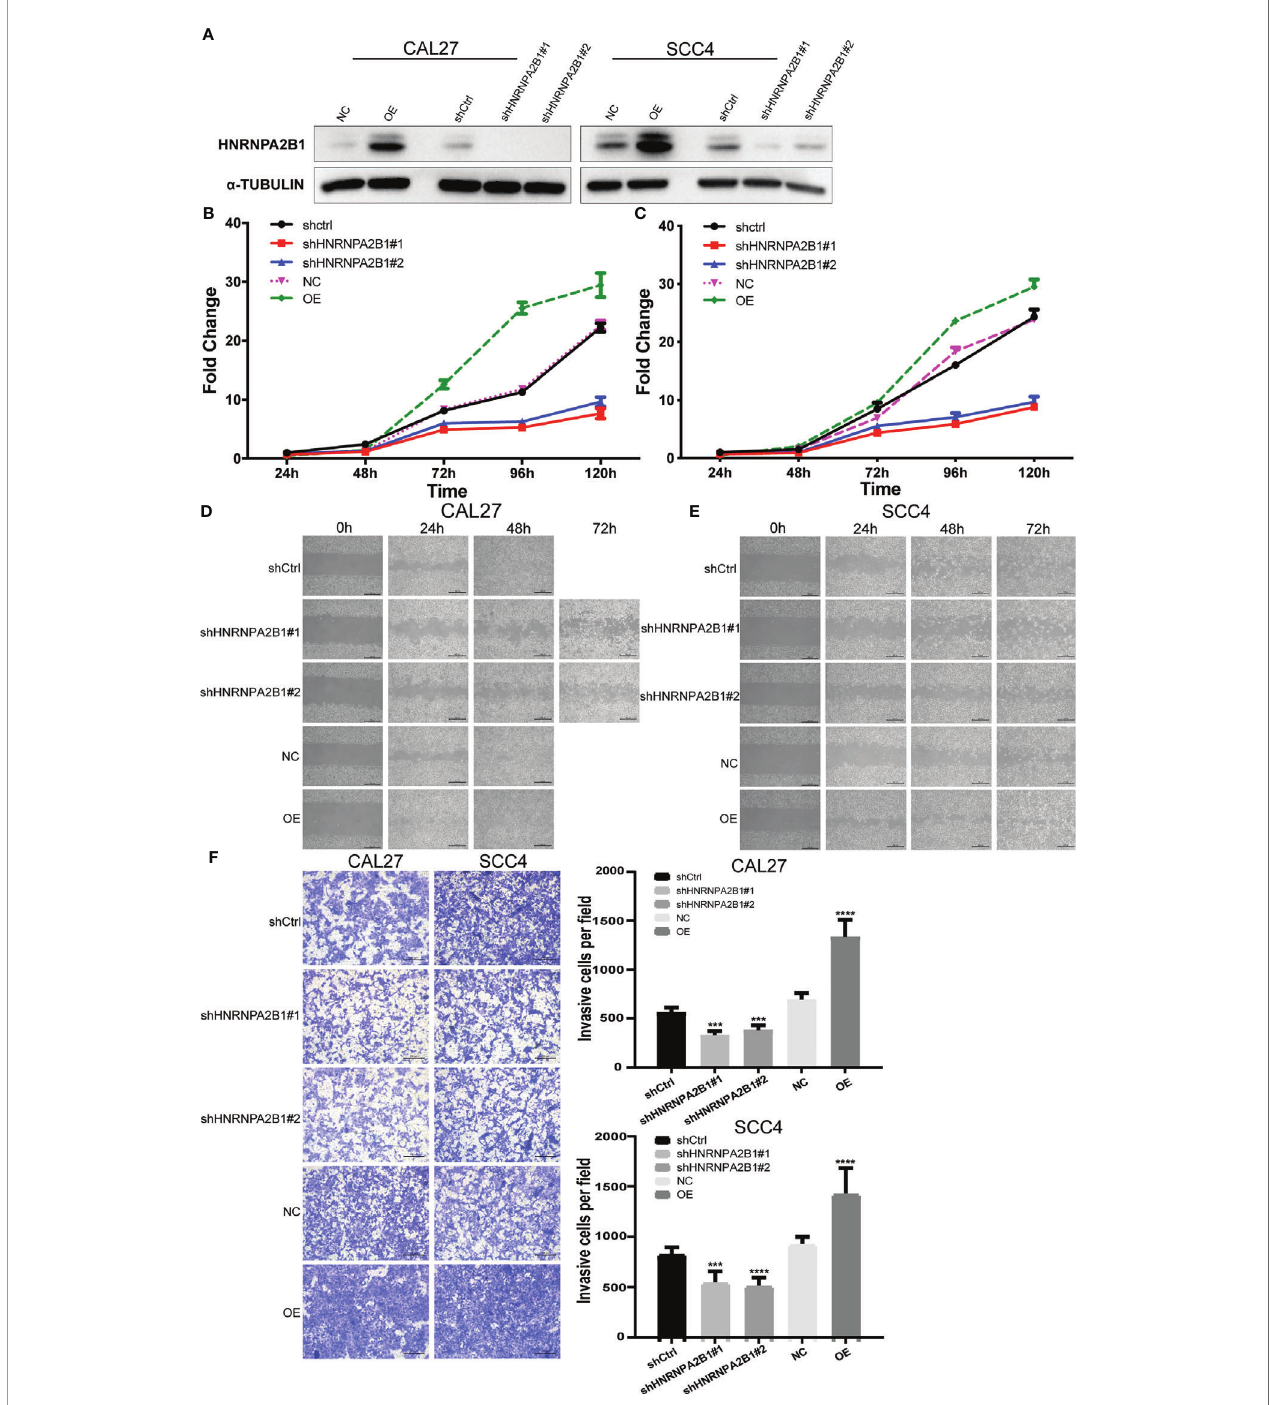
FIGURE 6 | The expression of HNRNPA2B1 signi fi cantly affected the proliferation, migration, and invasion in OSCC cell lines. (A) Western blot was used to detect the protein expression after stable knockdown or overexpress HNRNPA2B1 in CAL27 and SCC4 cell lines. (B, C) Knockdown of HNRNPA2B1 inhibited cell proliferation as indicated by CCK-8 assay in CAL27 and SCC4 cells. On the contrary, overexpression of HNRNPA2B1 could enhance its proliferation. (D, E) Wound healing assay showed that downregulation of HNRNPA2B1 inhibits cell migration while HNRNPA2B1 overexpression could increase cell migration in CAL27 and SCC4. (F) Trans-well assay showed that the invasion abilities of CAL27 and SCC4 cells were impaired after knocking down HNRNPA2B1 and were increased after overexpression of HNRNPA2B1 compared with those of the control group. The left panel shows the representative images. The right panel shows the statistic data of the left panel. The data are presented as the mean of three independent experiments. *** and **** indicated p<0.001 and p<0.0001,